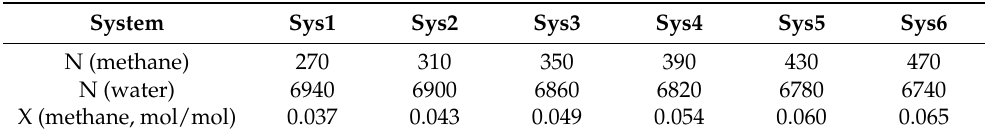
Table 1. The numbers of methane and water molecules and the mole fractions of methane in each